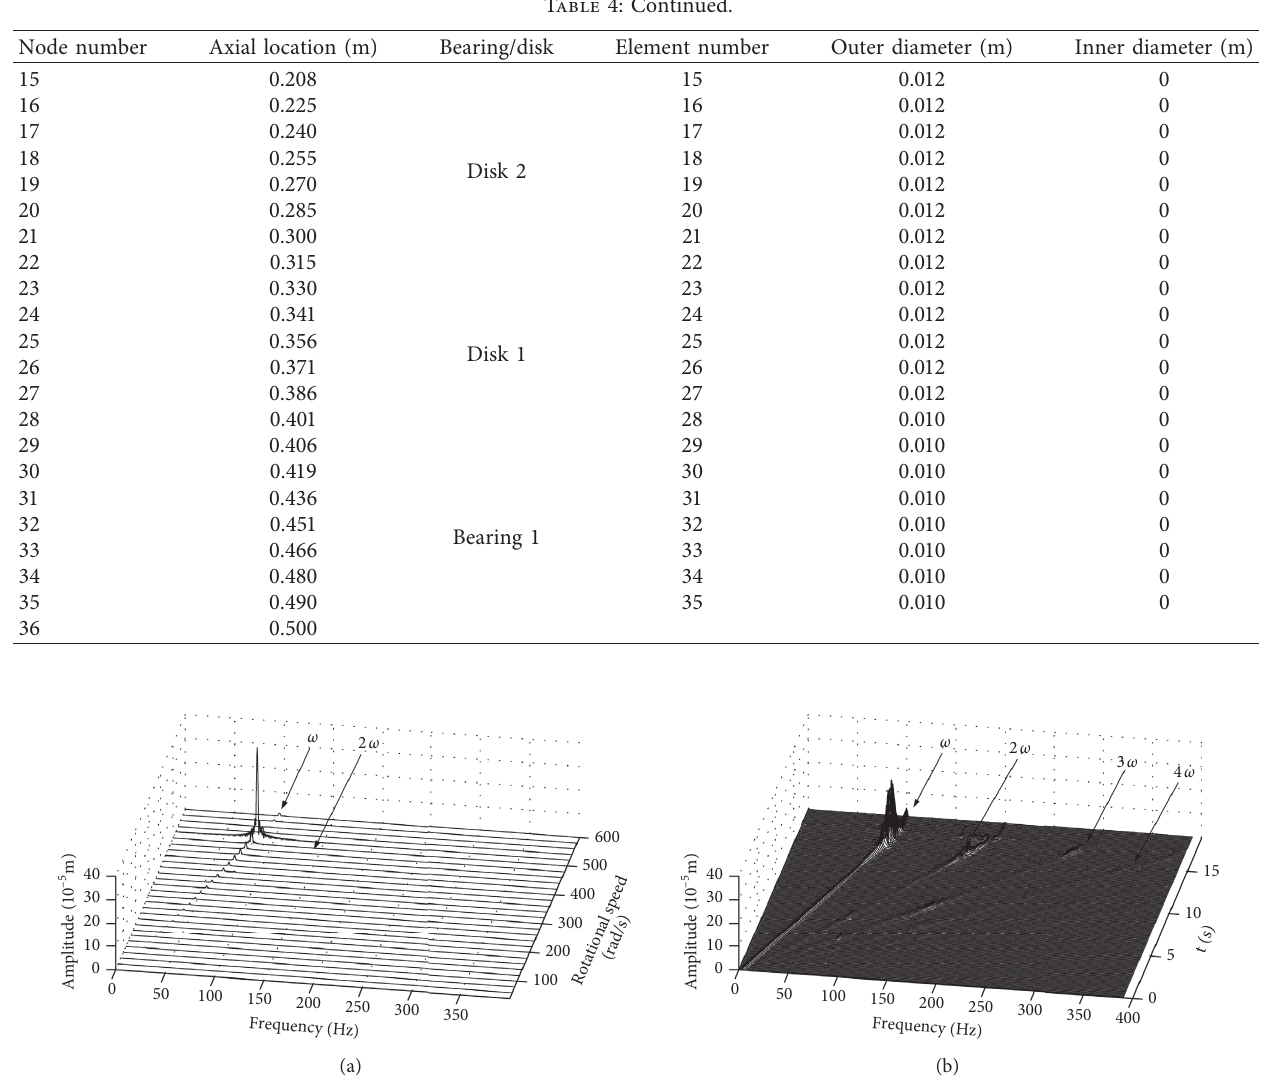
Figure 7: Waterfall spectra plots for the vibration of disk 3 without maneuver flight. (a) Numerical simulation. (b) Experimental results.